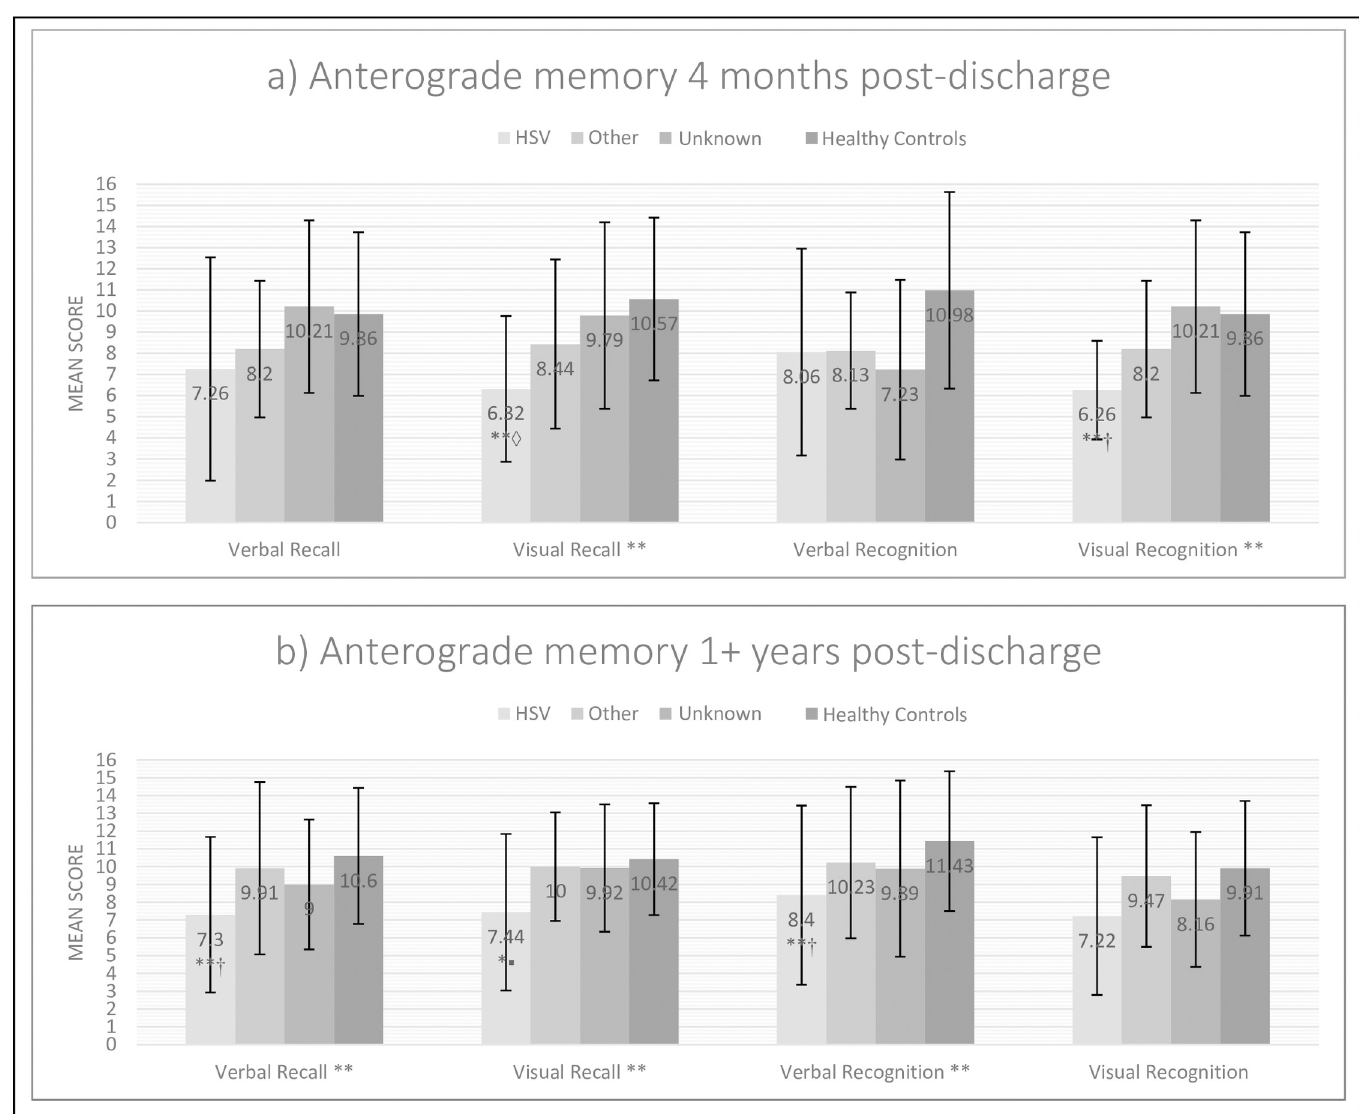
Fig 2. Mean anterograde memory scores for each aetiological group (Doors & People test). The error bars represent the standard deviation of the mean score within each group. (a) At the short-term assessment, a mean of 4 months post-discharge (in the short- and medium-term outcome cohort) and (b) at the long-term assessment, at least 1 year post-discharge (in the long-term outcome cohort). Notations: � p � 0.05, �� p � 0.01; † Hochberg GT2/Games-Howell post hoc (parametric); ■ Bonferroni- corrected pairwise analysis (ANCOVA post hoc). ^ Mann Whitney U post hoc